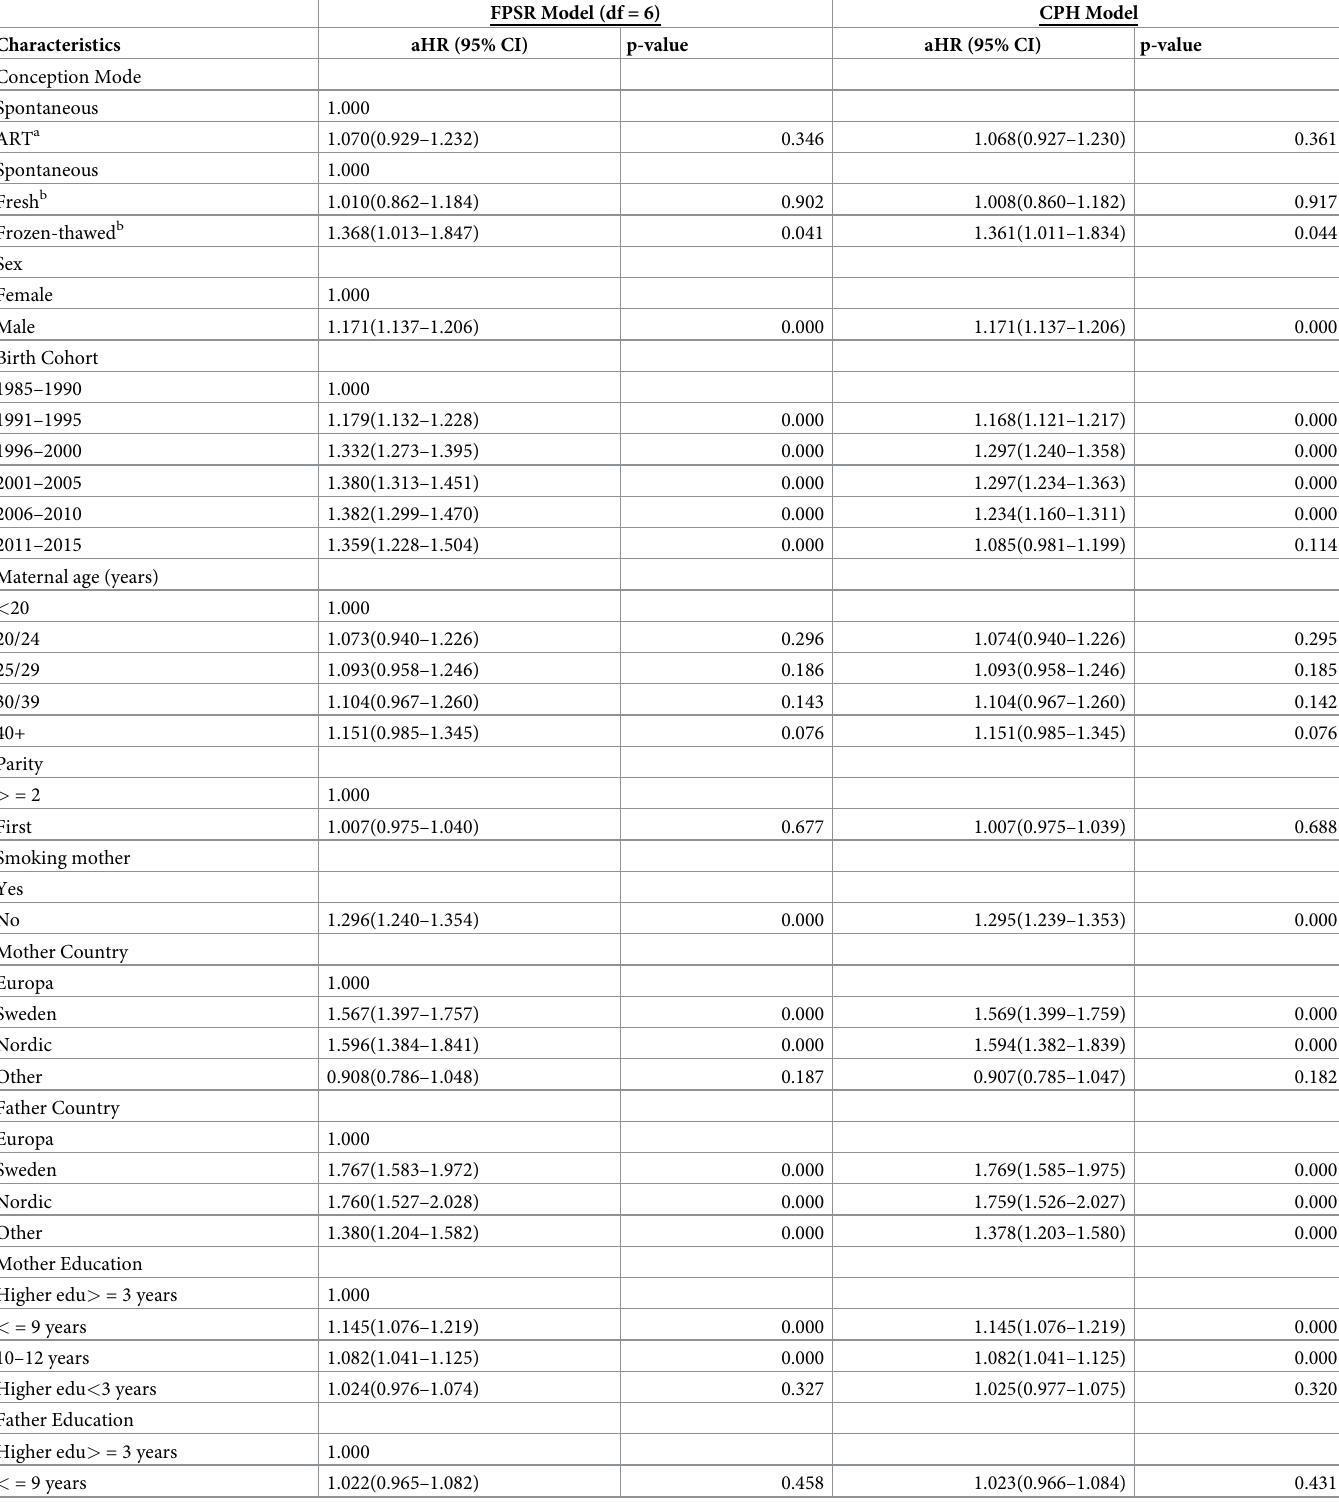
Table 4. Adjusted prognostic factors of type-1 diabetes among the studied Swedish cohort from CPH and FPSR model with 6 degrees of